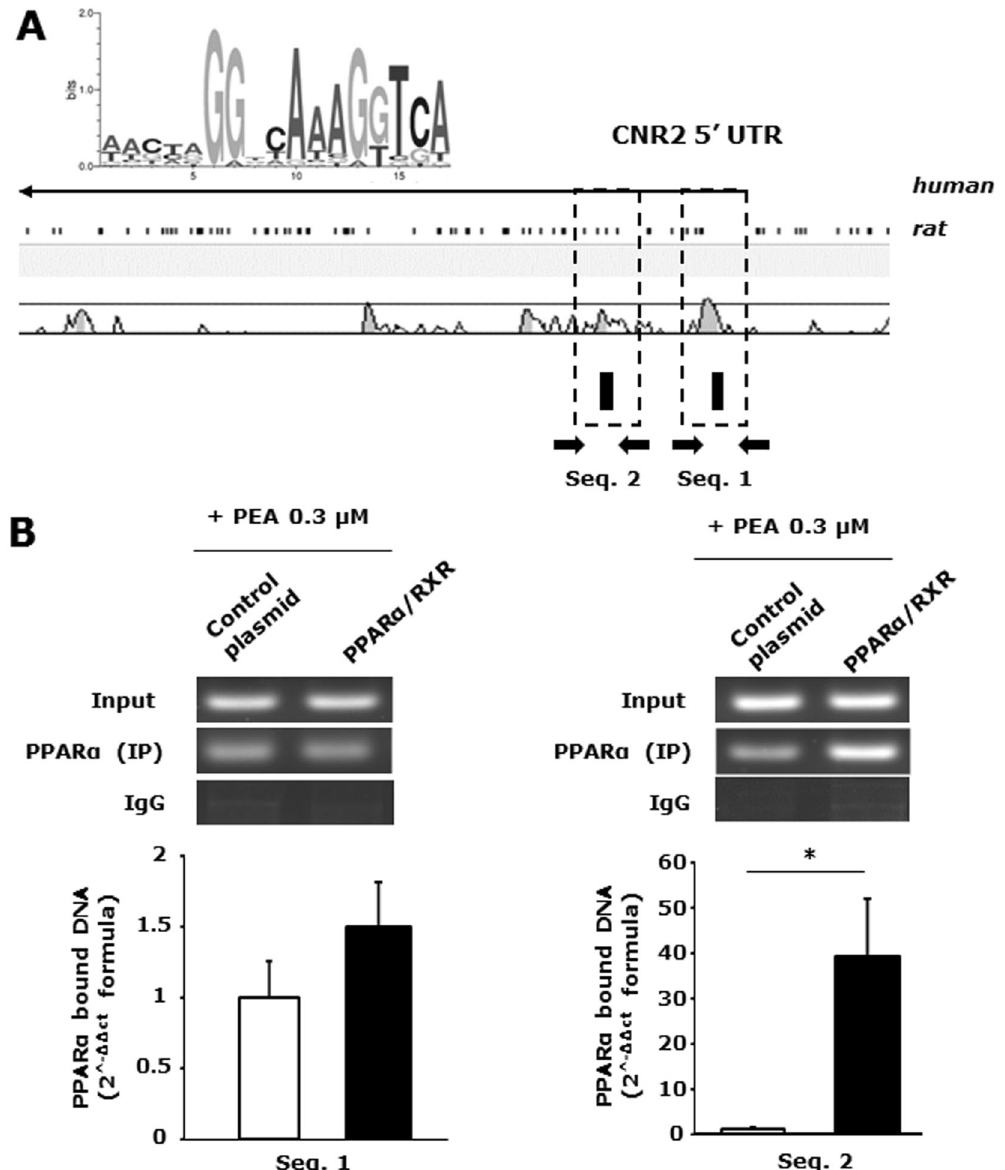
Figure 2. Cnr2 is directly regulated by PEA-mediated PPAR- α activation: bioinformatic analysis and chromatin immunoprecipitation assay. ( A ) A schematic alignment of the human and rat Cnr2 . The black boxes correspond to regions of high sequence homology between the two species contaning the putative PPAR α / RXR sites indicated as small black rectangles in the lower part below the schematic. The PPAR α /RXR matrix used for the analysis is also shown in the upper part. ( B ) Average data of the relative amount of the PPAR α -immunoprecipitated DNA in HEK293 cells transfected with either control (pCDNA3) or murine PPAR α and RXR encoding plasmids. Data are from three to six separate experiments and normalized relative to the input DNA, using the 2 −ΔΔ Ct formula. The inset shows a representative agarose gel electrophoresis of the qPCR products obtained from PAX7-immunoprecipitated DNA for each experimental condition. Data are shown as mean ± SEM (n = 3) of three independent experiments conducted in triplicate. * p value ≤ 0.05 vscontrol condition (pcDNA-transfected cells), obtained using the unpaired T-TEST for statistical